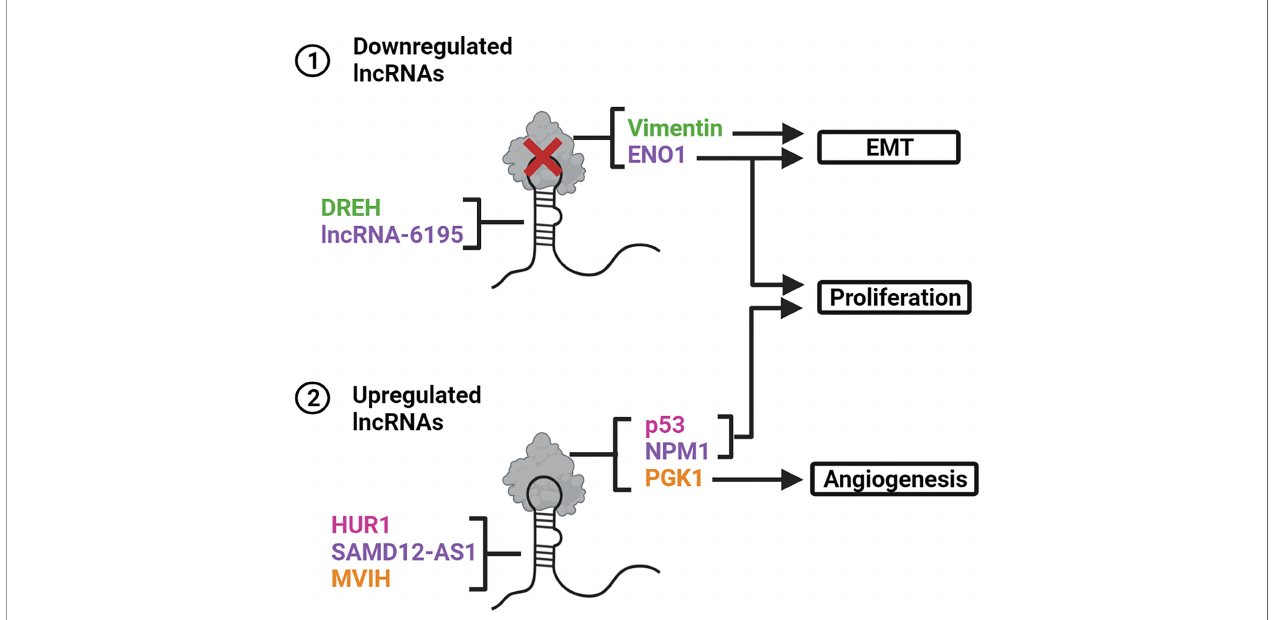
FIGURE 5 | LncRNAs interact with proteins and alter their stability or functionality. (1) DREH and LncRNA-6195 are downregulated in HBV-related HCCs. The lack of interaction between DREH and the protein vimentin promotes EMT. De fi cient binding of LncRNA-6195 to ENO1 promotes EMT and cell proliferation. (2) HUR1, SAMD12-AS1 and MVIH are upregulated in HBV-related HCCs. HUR1 and SAMD12-AS1 enhance cell proliferation by inhibiting p53 and NPM1, respectively. MVIH interacts with PGK1 to prevent its secretion thereby promoting angiogenesis. Created with